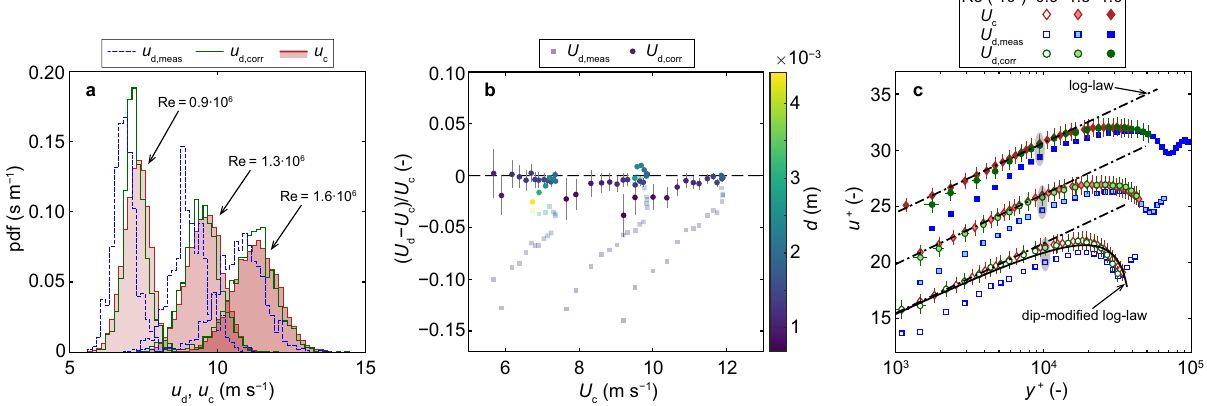
Fig. 4 Comparison of continuous-phase velocity u c measured with LDA to corrected and uncorrected (measured) dispersed-phase velocities u d,corr , u d,meas measured with CP. a Comparison of velocity histograms at y + ≈ 10 4 for different fl ows. b Mean velocity difference between dispersed and continuous phase with and without correction of interaction bias. Error bars indicate standard error (omitted for U d,meas for clarity). c Mean velocity pro fi les in inner scaling u + = U / u * compared to the log-law and dip-modi fi ed log-law 38 . Data for Re = 0.9 ⋅ 10 6 shifted by Δ u + = − 5 and for Re = 1.6 ⋅ 10 6 by Δ u + = + 5. All mean velocities were scaled with u * obtained from LDA measurements using the Clauser method. Gray ellipses highlight data shown in a , error bars indicate standard error (omitted for U d,meas for